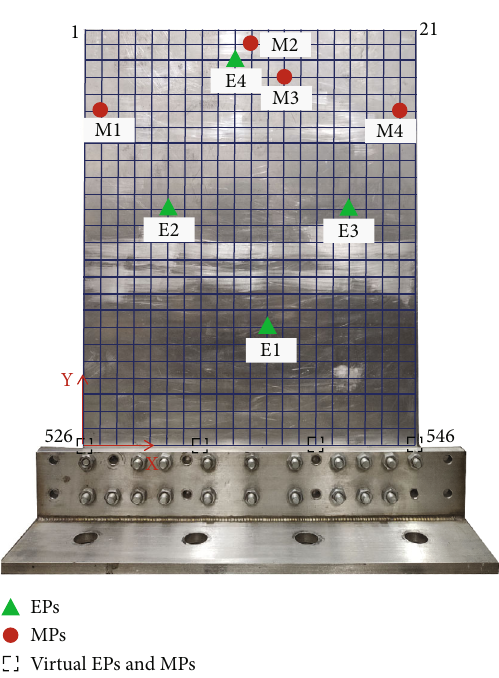
Figure 8: Locations of the EPs and the